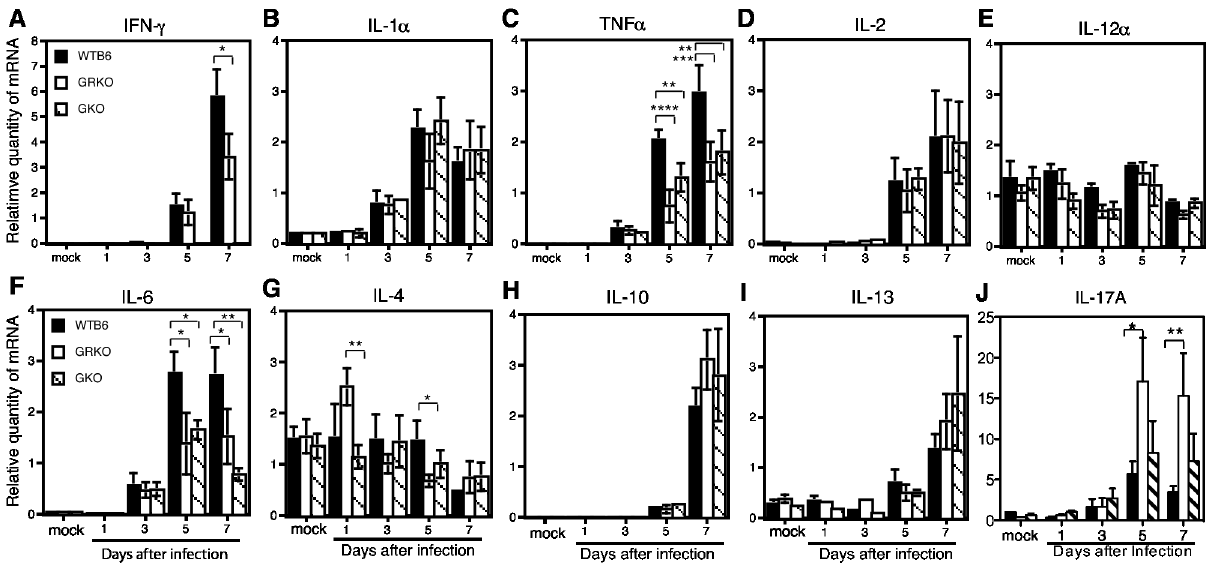
Figure 8. Quantification of cytokine mRNA levels in the brain. Quantitative RT-PCR was used to measure the levels of IFN- gamma (A), IL-1alpha (B), TNF-alpha (C), IL-2 (D), IL-12alpha (E), IL-6 (F), IL-4 (G), IL-10 (H), IL-13 (I) and IL-17A (J) mRNAs in the brains of uninfected (mock) and NSV-infected WTB6, GKO and GRKO mice. Cytokine mRNAs were normalized to beta-actin mRNA. Data are from 3 animals from each group at each time point and 2-4 experimental replicates. Bars indicate the mean and SEM for each group. * P < 0.05, ** P < 0.01, *** P < 0.001, **** P < 0.0001; ANOVA. doi: